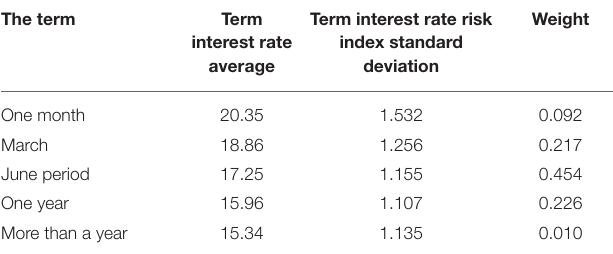
TABLE 3 | Interest rates and risks for different borrowing